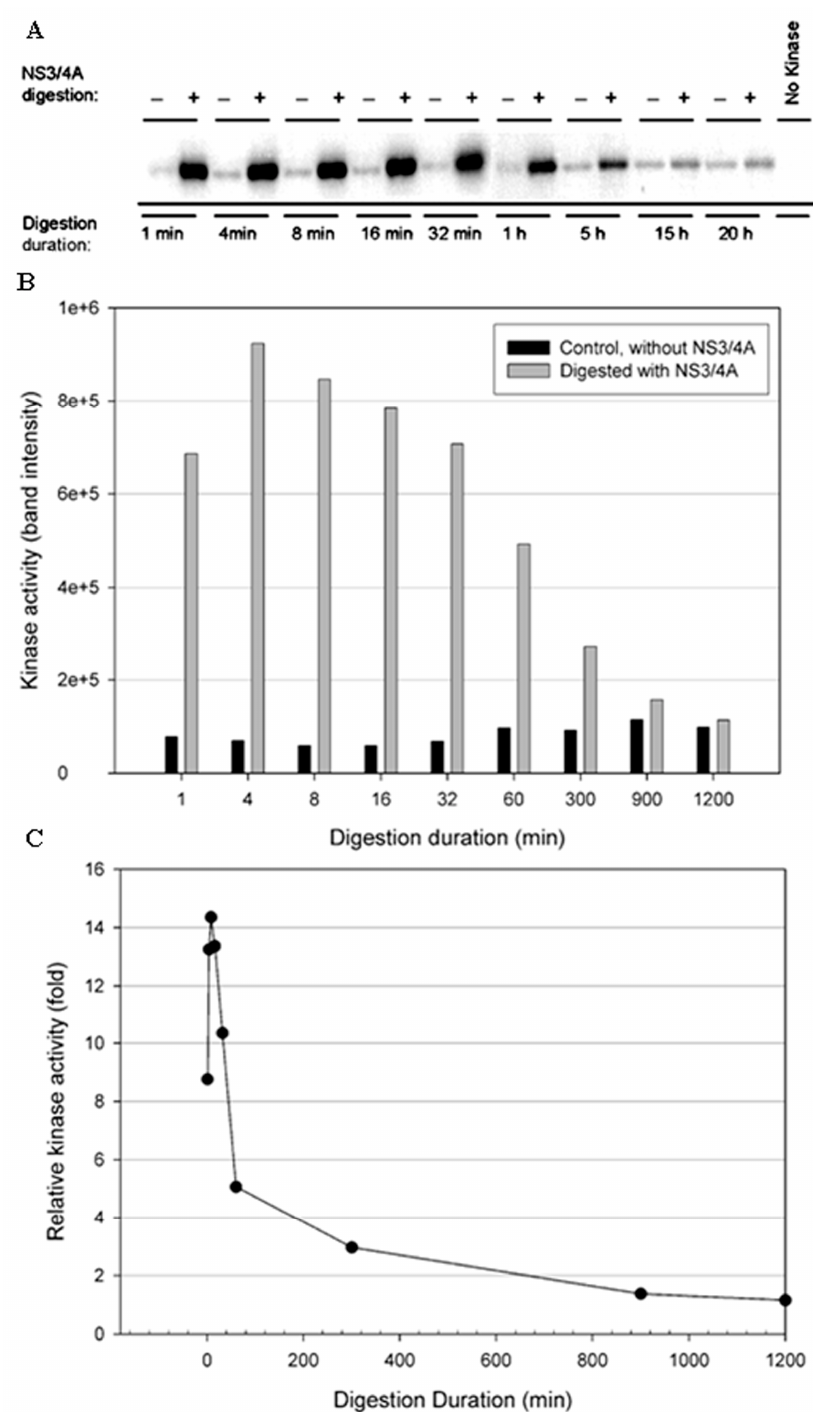
Figure 7. Effect of NS3/NS4A digestion on TBK1 kinase activity in a time-dependent manner. The kinases (0.5 μ g) were treated with NS3/NS4A (1.25 μ M NS3 + 325 μ M NS4A). ( A ) TBK1 was treated with or without NS3/4A up to 20 h. The kinase activity was tested using GST-I κ B α (residues 5–55) and [ γ - 32 P] ATP as substrates. Phosphorylated GST-I κ B α bands were detected by a PhosphoImager. ( B ) The band intensities detected by the PhosphoImager were plotted versus time. ( C ) The relative kinase activities (TBK1 treated with NS3/NS4A versus untreated control) were plotted versus time.